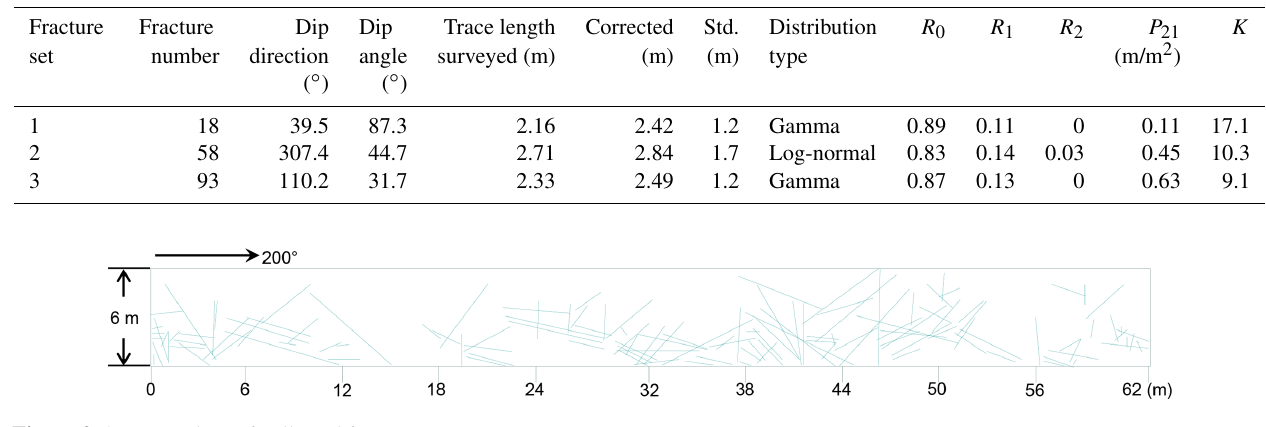
Figure 2. 2D trace chart of collected